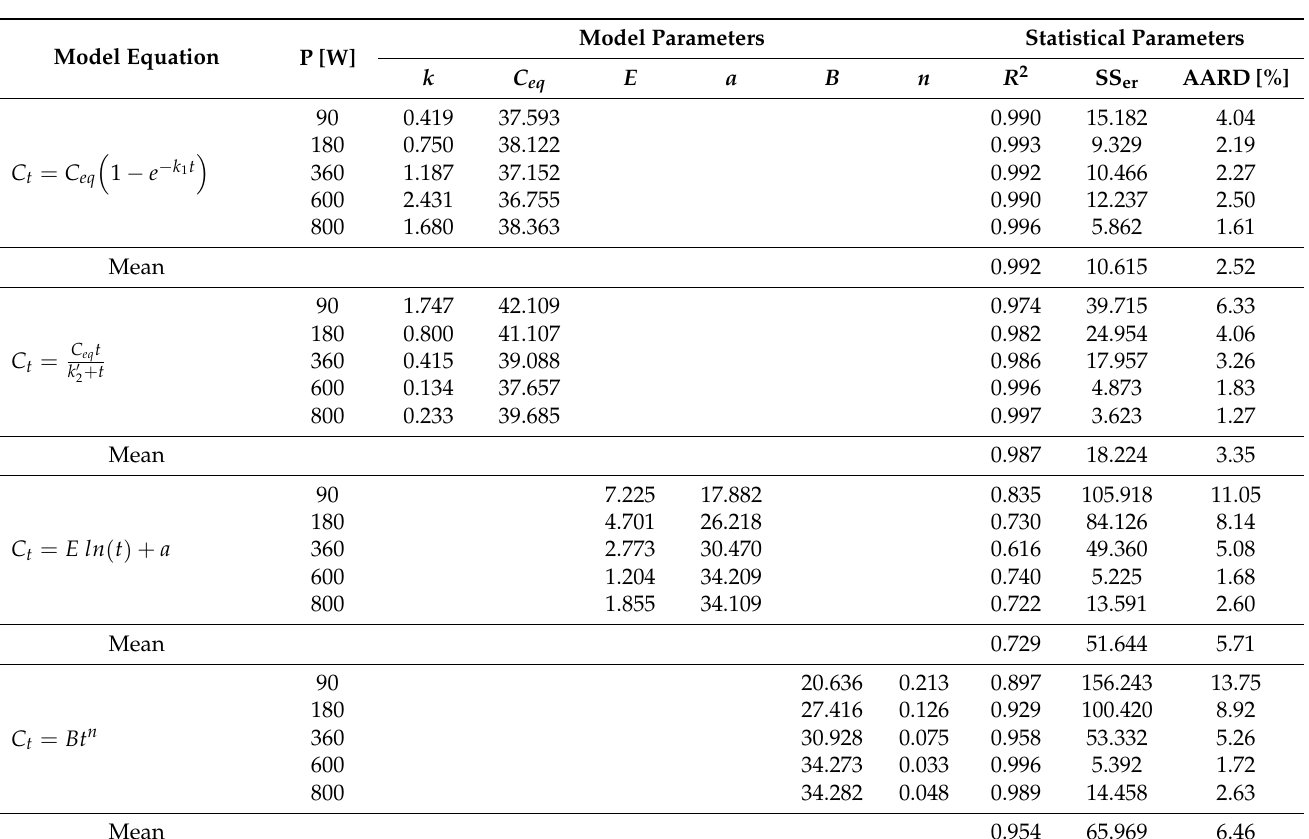
Table 1. Calculated parameters and statistical data of four empirical models applied for MAE kinetics of total extraction